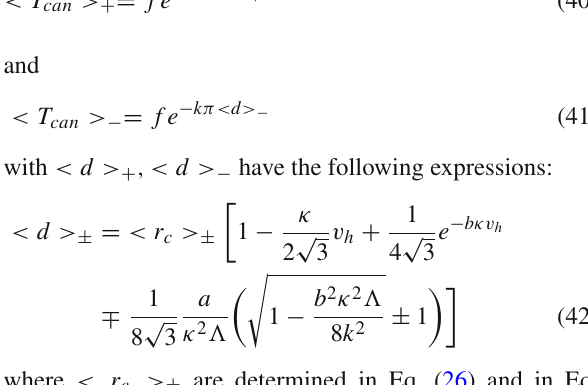
(cid:9) for a = 1, b =